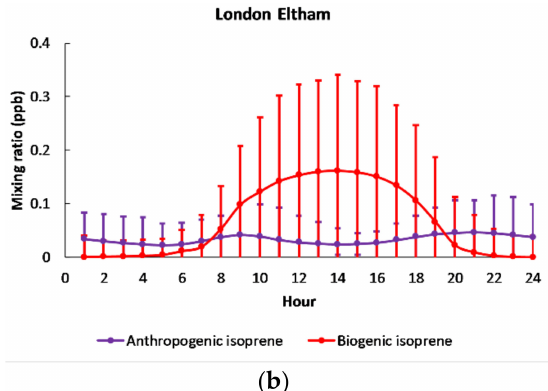
Figure 3. The diurnal average mixing ratios of anthropogenic and biogenic isoprene for the period of 1997–2017 ( a ) London Marylebone Road, ( b ) London Eltham. Note: The error bar represents ± 1 SD of the whole data